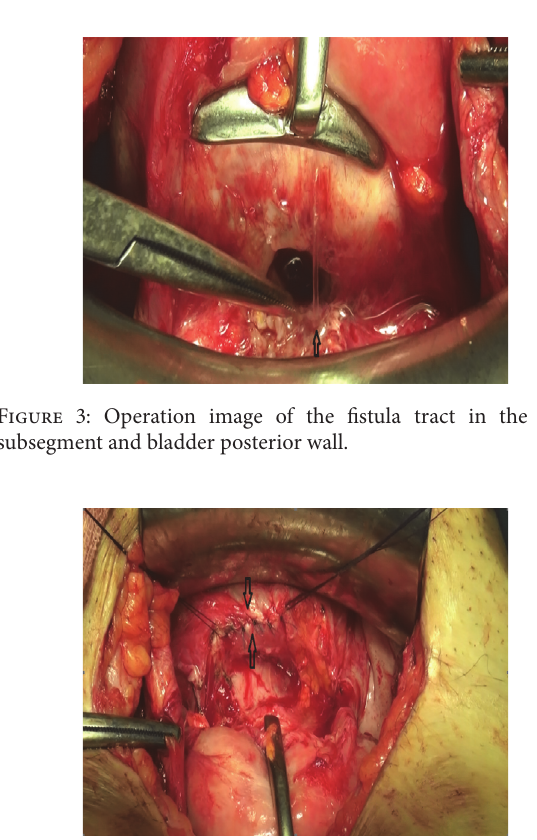
Figure 4: Dissection of the vesicouterine gap and repair of the